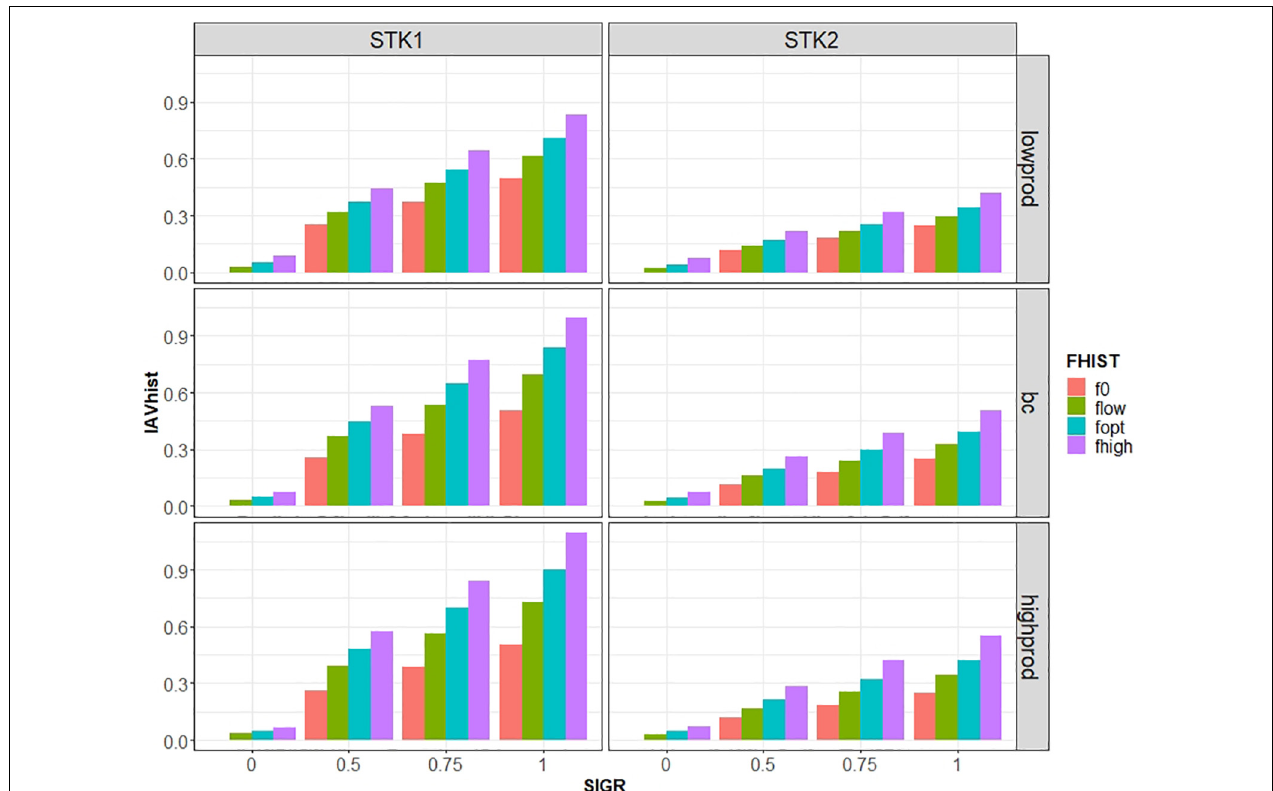
FIGURE 2 | Interannual variation in the historic period (IAVhist) by standard deviation for the recruitment log-normal error (SIGR, x-axis) as a function of the stock type: anchovy-like (STK1) and sprat/sardine-like (STK2); stock productivity: low (lowprod), medium (bc) and high (highprod); and the exploitation level: zero catch (f0), under exploitation (flow), fully exploited (fopt) and overexploitation (fhigh). Interactive version of the figure is available online at https://aztigps.shinyapps.io/Sanchezetal2021_FMS/.